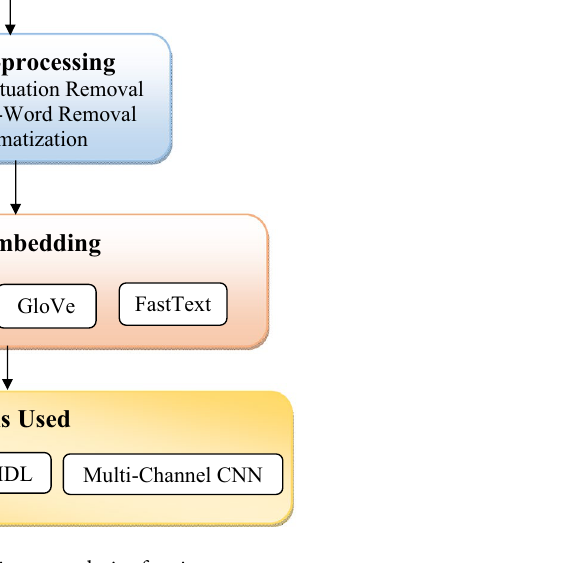
Figure 1. Steps involved in sentiment analysis of